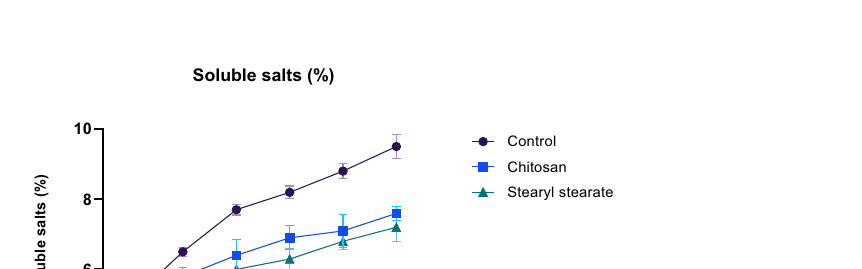
Figure 5. Ascorbic acid content of stored tomatoes.